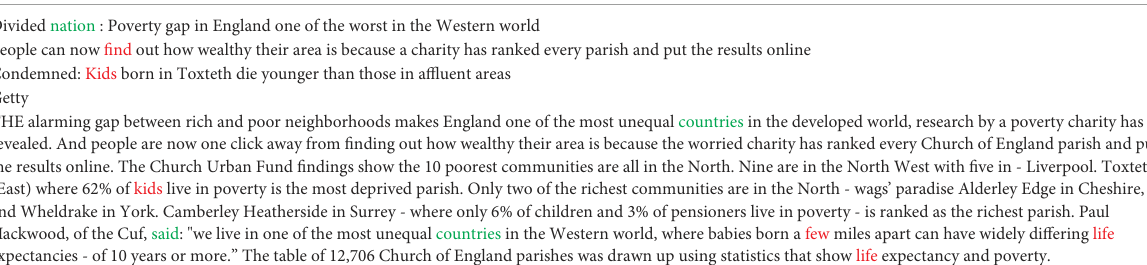
TABLE 8 An excerpt of an article with the top 100 keywords highlighted for news in green and for blogs in red extracted with SVMs (upper part) and TDK (lower part). Divided nation: Poverty gap in England one of the worst in the Western world People can now find out how wealthy their area is because a charity has ranked every parish and put the results online Condemned: Kids born in Toxteth die younger than those in affluent areas Getty THE alarming gap between rich and poor neighborhoods makes England one of the most unequal countries in the developed world, research by a poverty charity has revealed. And people are now one click away from finding out how wealthy their area is because the worried charity has ranked every Church of England parish and put the results online. The Church Urban Fund findings show the 10 poorest communities are all in the North. Nine are in the North West with five in - Liverpool. Toxteth (East) where 62% of kids live in poverty is the most deprived parish. Only two of the richest communities are in the North - wags’ paradise Alderley Edge in Cheshire, and Wheldrake in York. Camberley Heatherside in Surrey - where only 6% of children and 3% of pensioners live in poverty - is ranked as the richest parish. Paul Hackwood, of the Cuf, said: "we live in one of the most unequal countries in the Western world, where babies born a few miles apart can have widely differing life